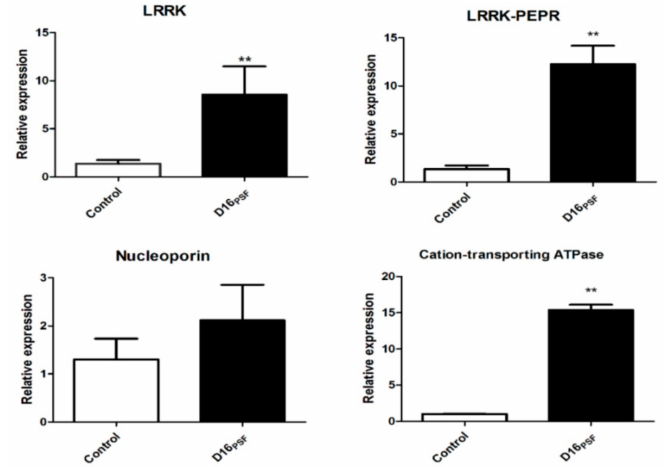
Figure 7. Relative expression of leucine-rich repeat protein kinase (LRRK), leucine-rich repeat protein kinase PEPR (LRR-PEPR), cation-transporting ATPase, and nucleoporin after D16 PSF treatment on the fourteenth day. Values are presented as means ± SD ( n = 3). * p < 0.05; ** p < 0.01 versus the control